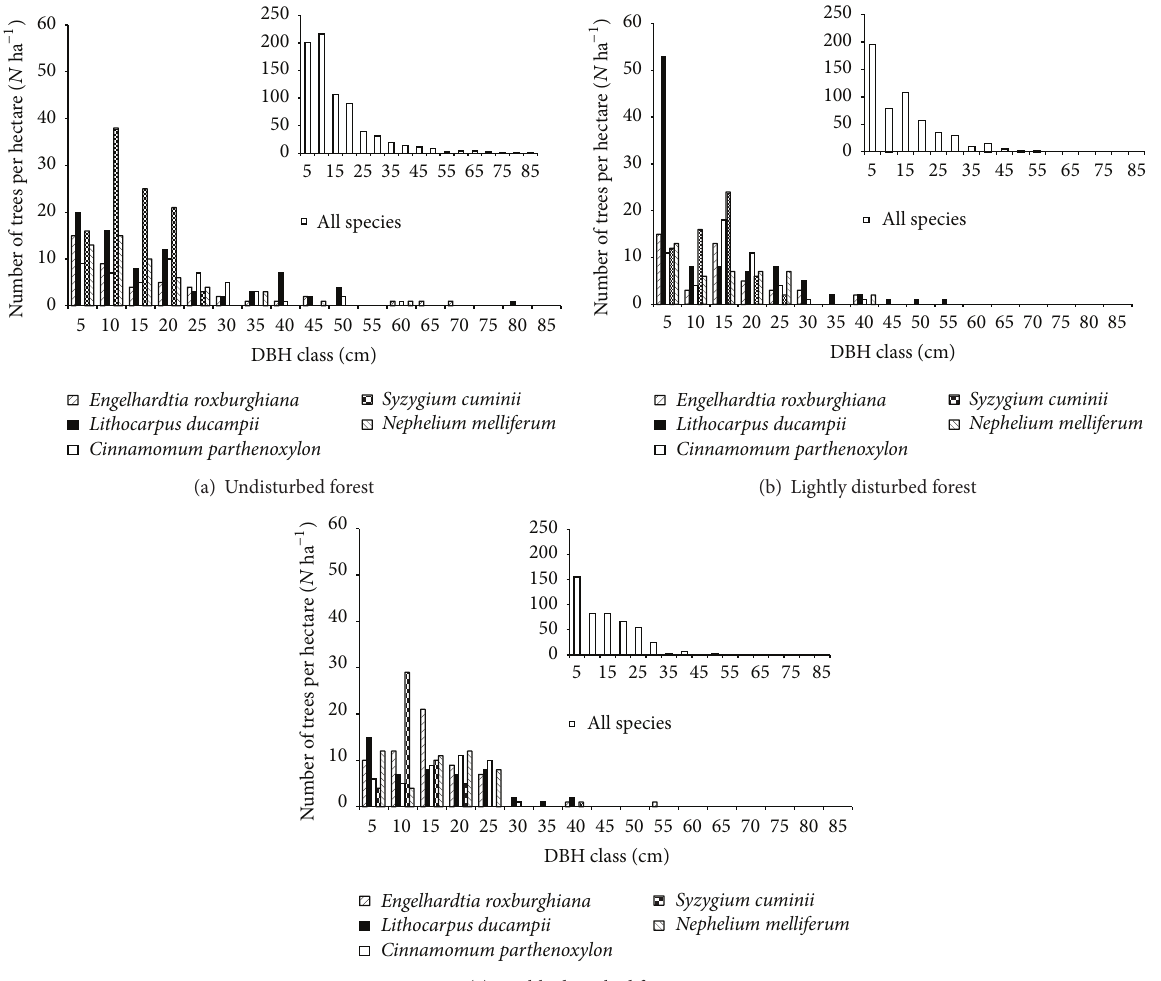
Figure 4: Diameter distributions of all living trees and the five major tree species in each forest type in Xuan Nha Nature Reserve, Vietnam.